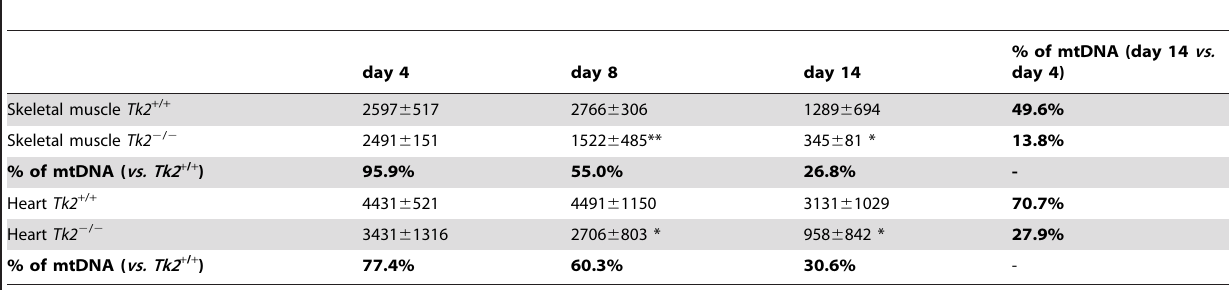
Table 2. mtDNA copy number per diploid nucleus in skeletal muscle and heart of Tk2 + / + and Tk2 2 / 2 pups at 4, 8 and 14 days after birth.